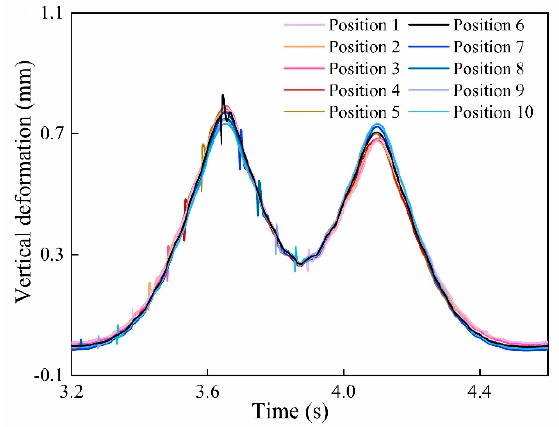
Figure 9. The impact response curves of the wheel flat under the different impact positions at 20 km/h.